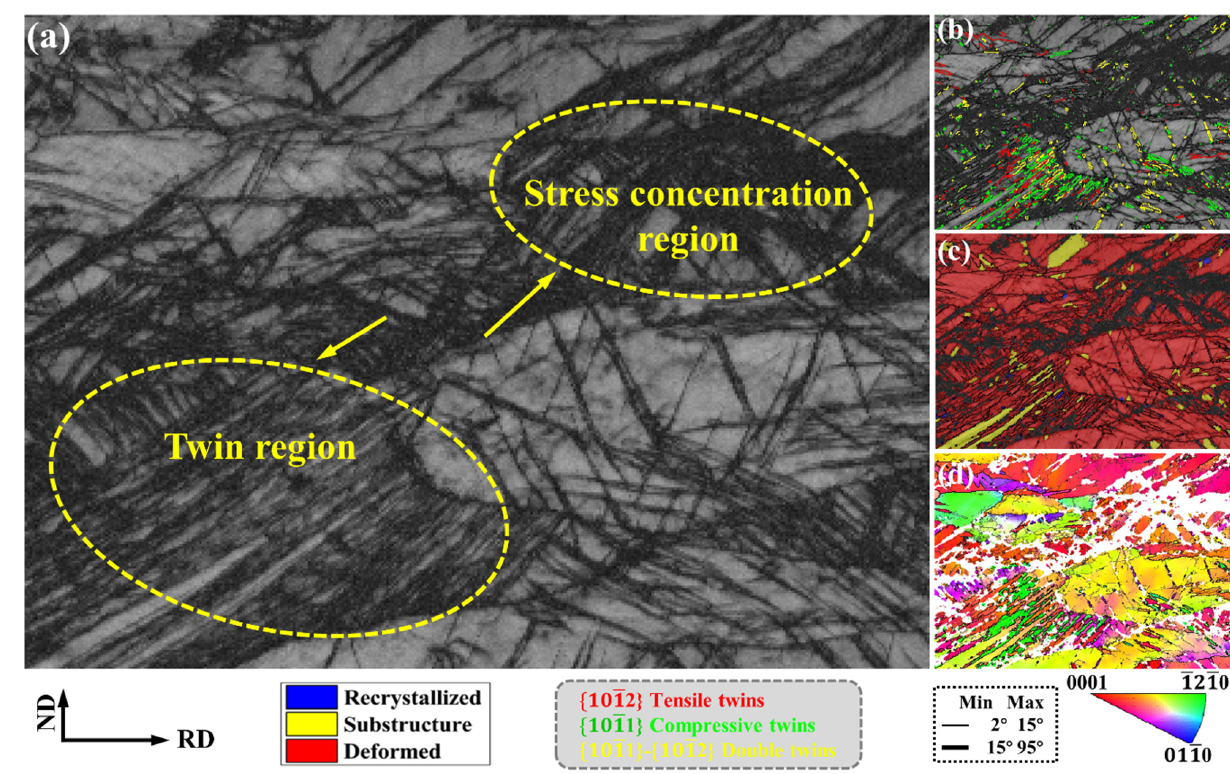
Figure 2. The EBSD result of the as-rolled structure of magnesium alloy: ( a ) BC map; ( b ) distribution of different twins; ( c ) distribution of different microstructures; and ( d ) IPF map.